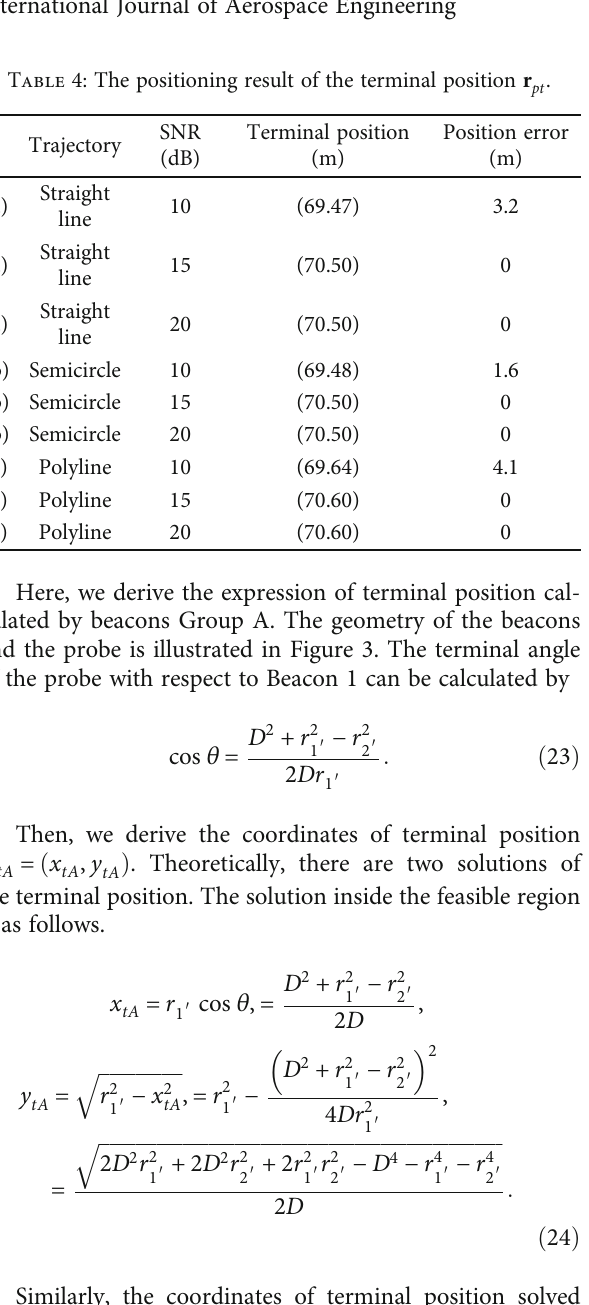
Table 4: The positioning result of the terminal position r